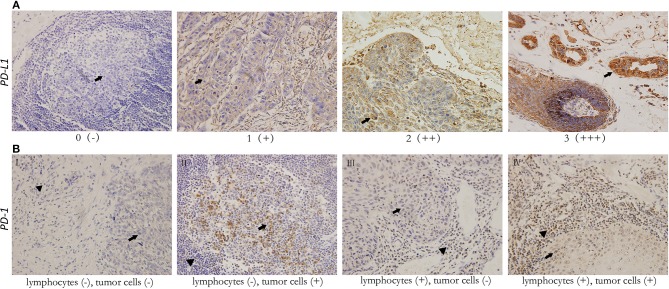
Representative immunohistochemical staining for PD-L1 (×200) in head and neck squamous cell carcinoma, and PD-1 (×200) in both tumor cells and tumor-infiltrating lymphocytes. All images show both tumor cell area (arrowhead) and lymphocytes (filled arrowhead). (A) For PD-L1, scores 0, 1, 2, 3 represent negative (–), weak positive (+), moderate positive (++), and strong positive (+ + +) expression, respectively. (B) Various expression patterns of PD-1 in tumor tissues (I. PD-1- tumor with PD-1- TILs II. PD-1+ tumor with PD-1- TILs III. PD-1- tumor with PD-1+ TILs IV. PD-1+ tumor with PD-1+ TILs).